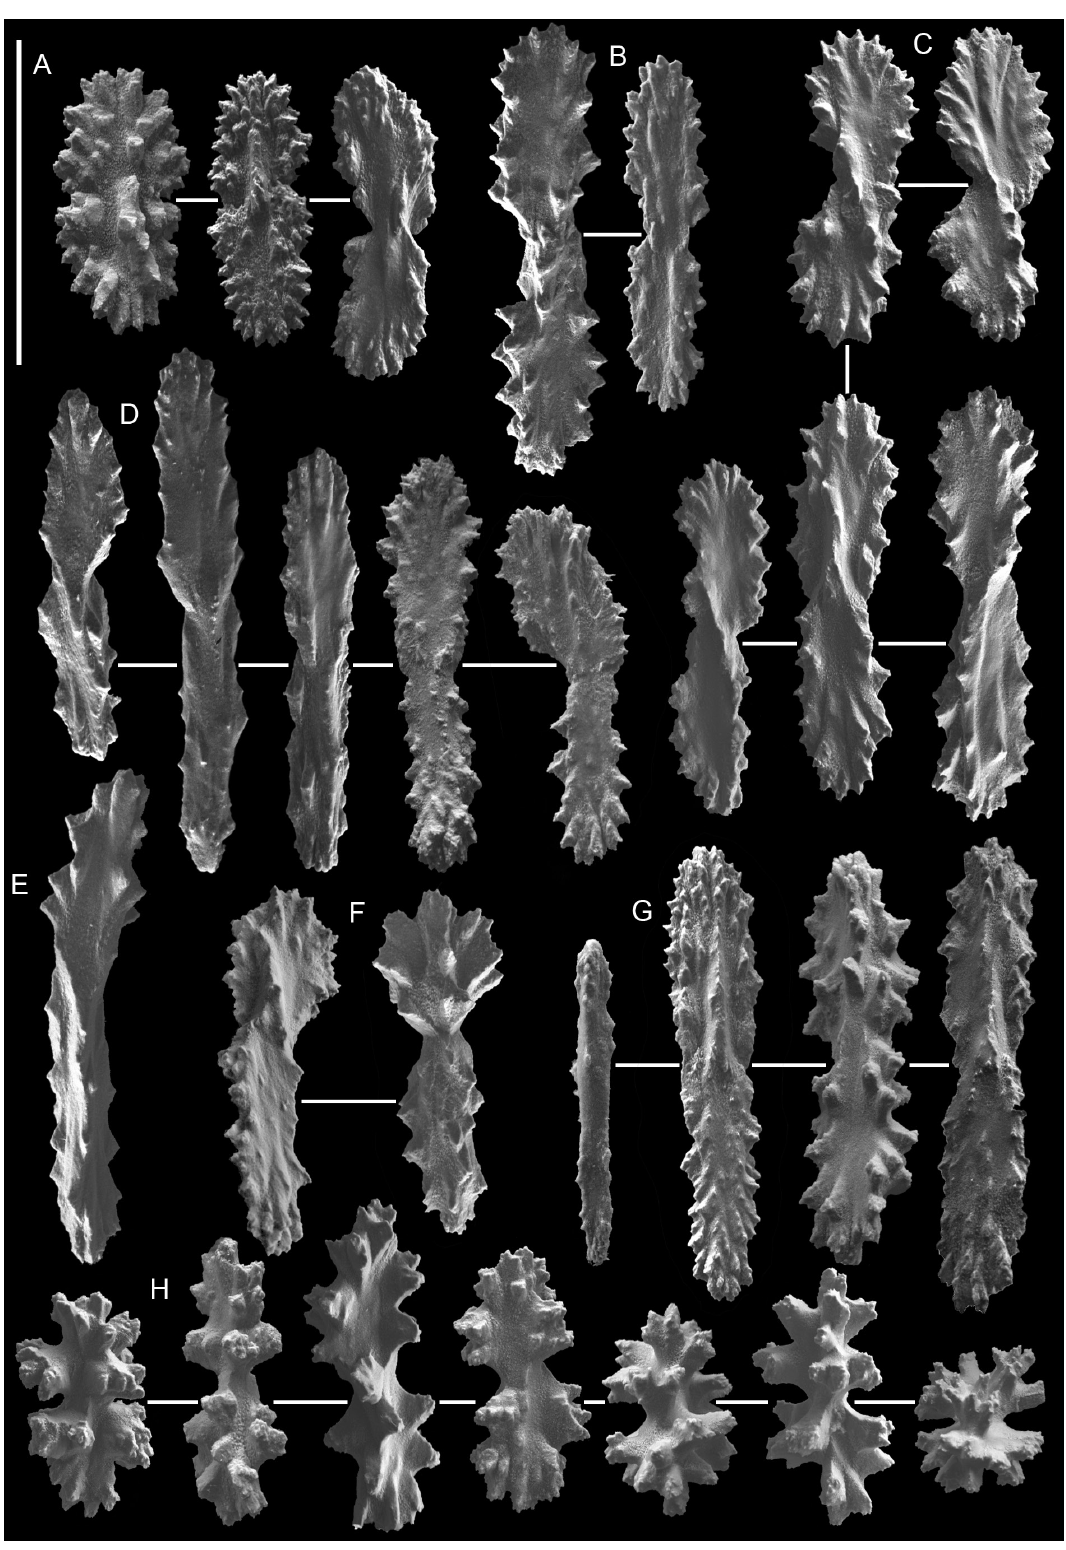
Fig. 7. Heteropolypus roseus sp. nov., holotype (MIMB 42495); sclerites from the autozooid tentacles. A . Waisted plates. B . Plates. C . Plates with diagonal keel. D . Asymmetrical plates. E . Club-like spindle. F . Clubs. G . Warty spindles. H . Capstans. Scale bar = 0.1